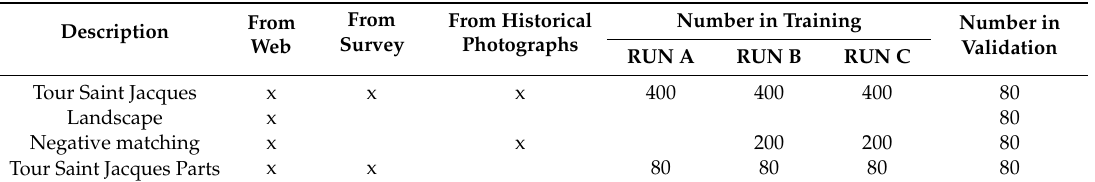
Table 1. Description of the training and validation dataset 1 on the reference case of the Tour Saint Jacques.